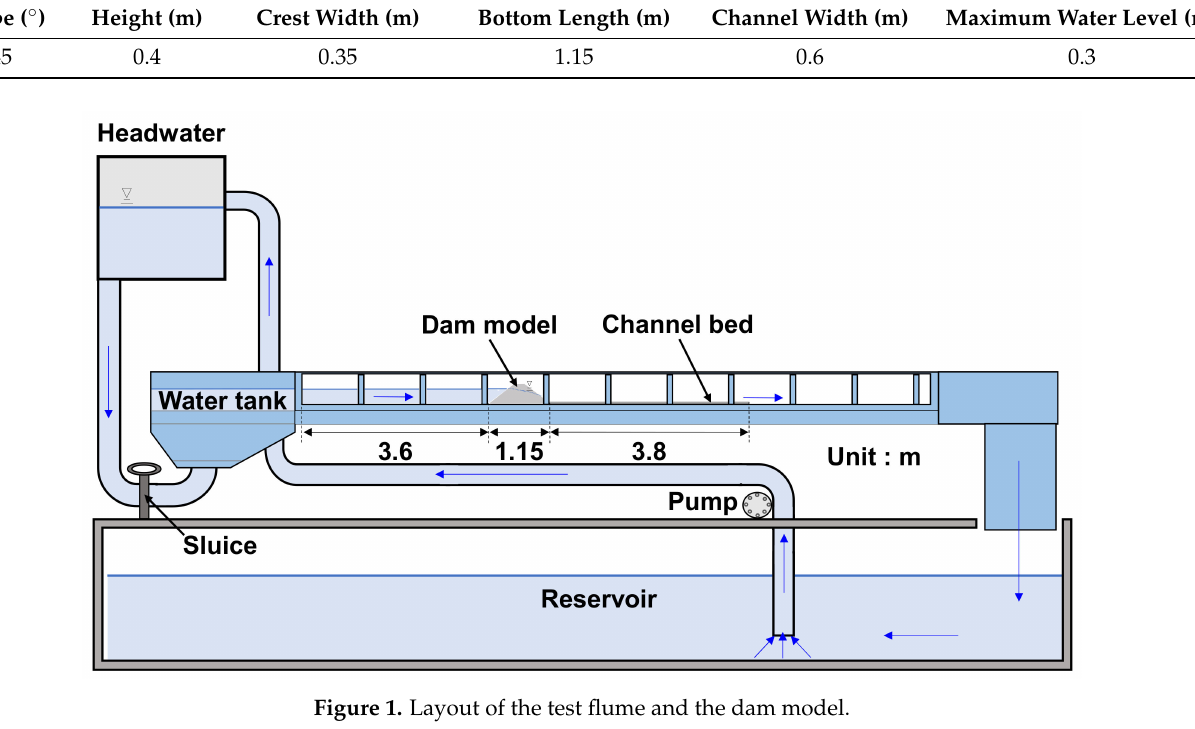
Table 1. The dimensions of the dam model.